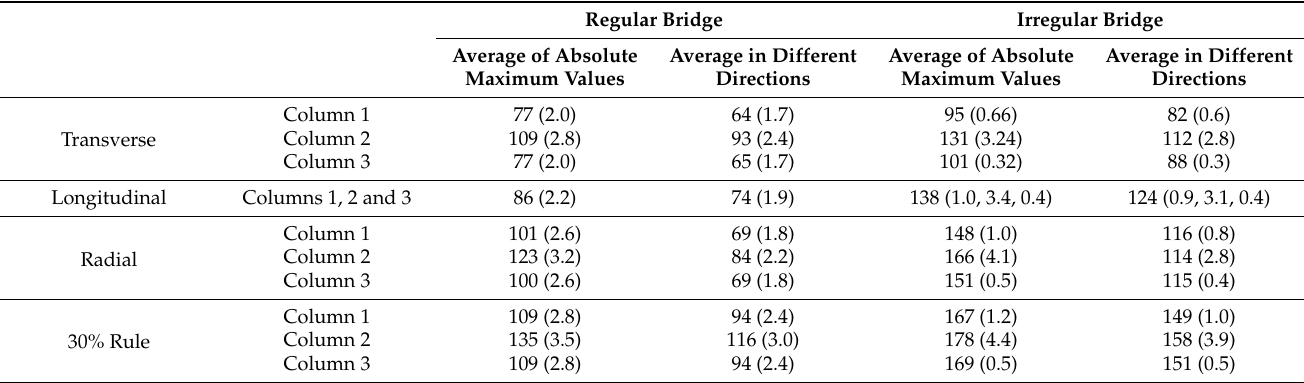
Figure 7. The maximum displacements obtained from 22 records using the maximum absolute displacements for: ( a ) regular bridge; ( b ) irregular bridge; and using the negative and positive displacements for: ( c ) regular bridge; ( d ) irregular bridge. Table 2. Summary of the mean displacements (mm) of columns using 3D analysis for the regular and irregular bridges with mean ductility demands given in brackets.